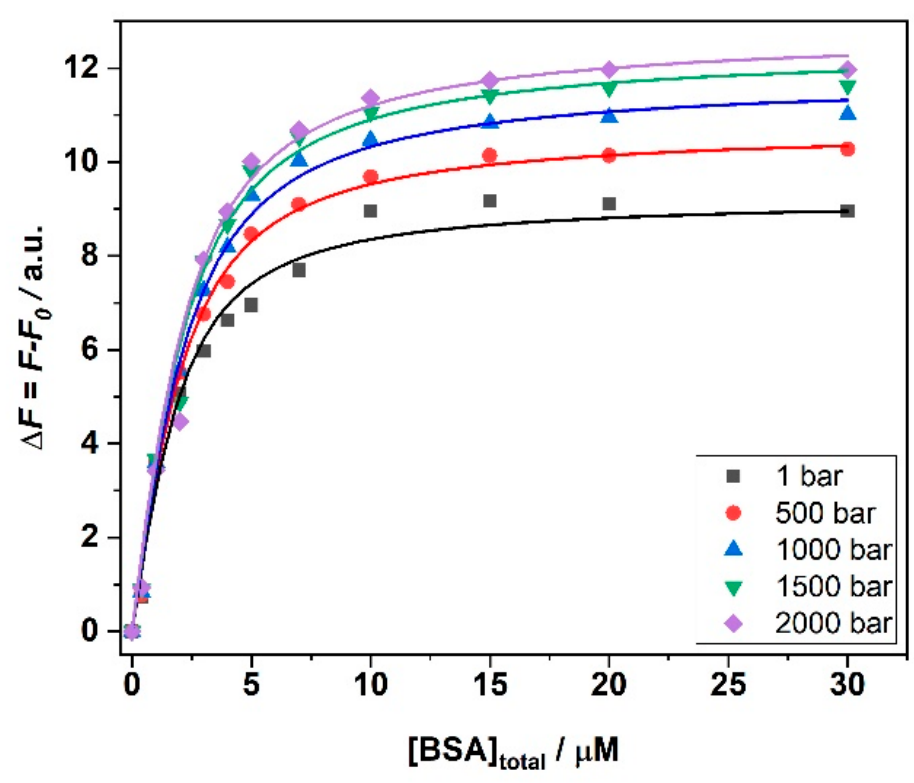
Figure 4. Binding isotherms for ANS/BSA complex formation obtained at T = 25 ◦ C in the presence of 250 mM MgCl 2 , at the indicated pressure values. The solid lines represent the best fit of experimental data according to an equivalent and independent binding sites model. All the experiments were performed in 10 mM Tris-HCl buffer. The binding isotherms were obtained by plotting ∆ F = F − F 0 (where F is the fluorescence intensity of ANS at the maximum in the presence of BSA, and F 0 is the intensity of ANS in the absence of BSA) as a function of the total BSA concentration. Table 2. Binding constants ( K b ) and stoichiometries ( n ) for the BSA:ANS complex formation in 10 mM Tris-HCl buffer, pH 7.4, in the presence of the indicated salts, temperatures, and pressures.